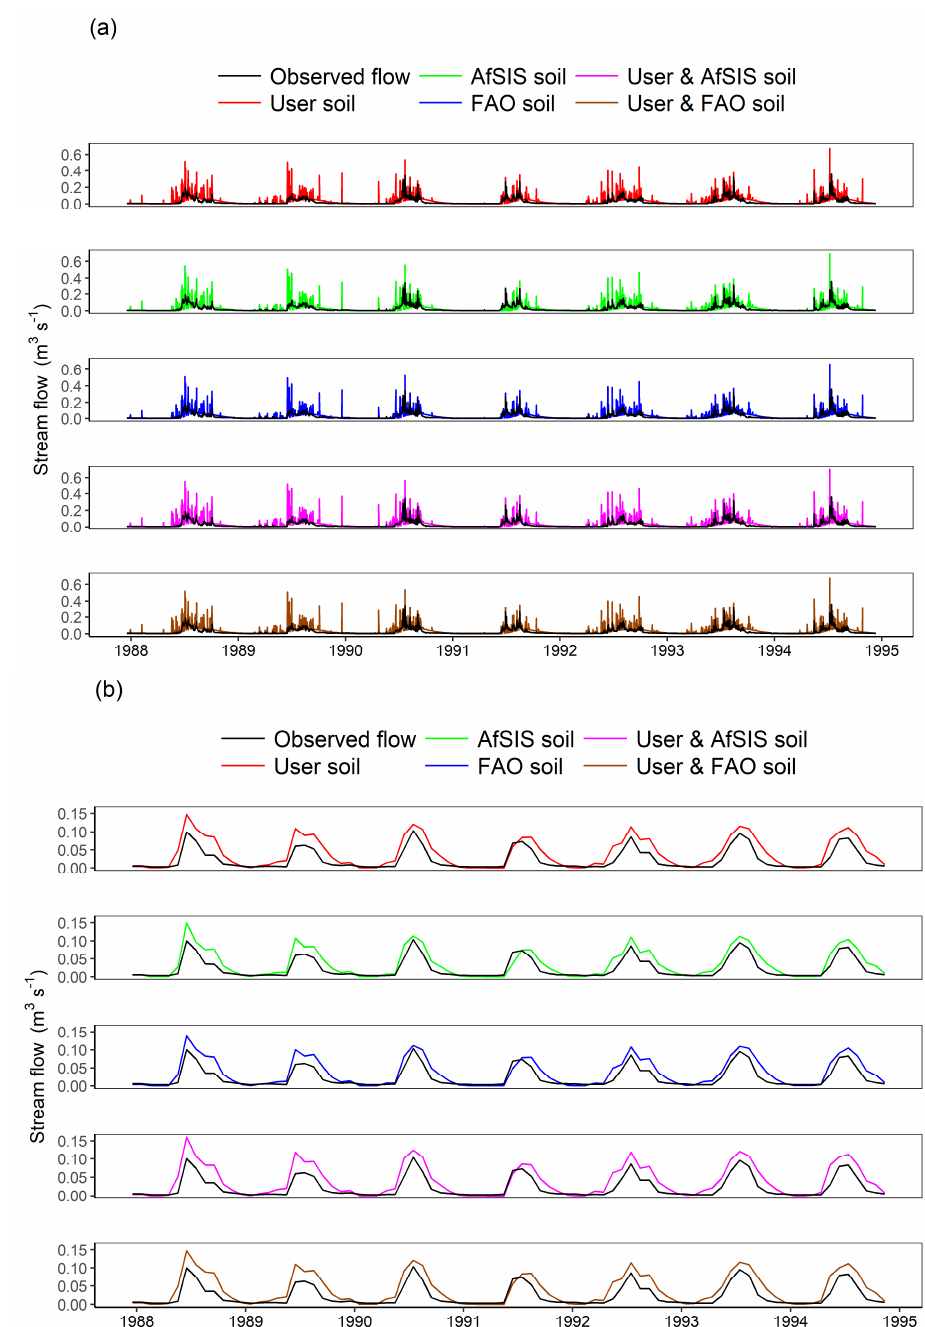
Figure 5. Comparison of measured and simulated streamflow before model calibration at the watershed outlet. Daily simulations ( a ) and monthly simulations ( b ).